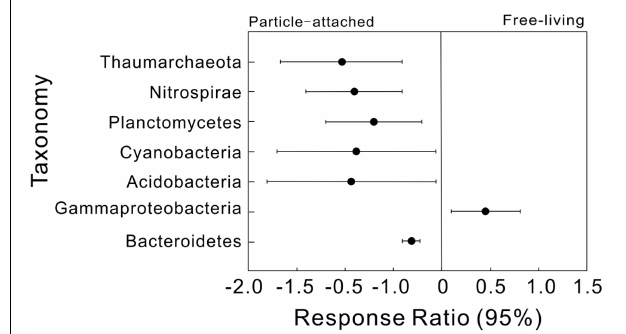
FIGURE 3 | Response ratio analysis of taxonomic changes in particle-attached (UP and DP) and free-living networks (UF and DF). Values greater than zero indicate increased relative abundances in the free-living networks, while those less than zero indicate microbes enriched in particle-attached